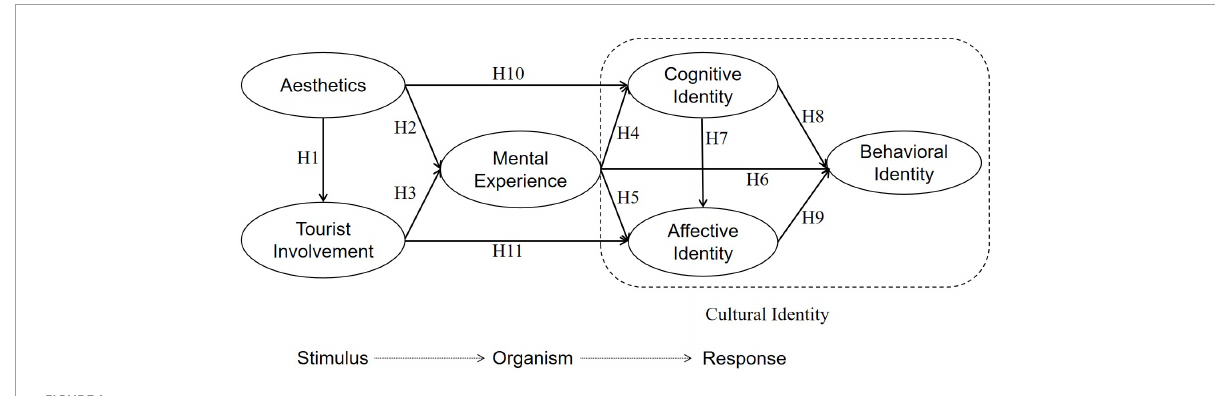
FIGURE1 Tourists’ cultural identity framework in heritage tourism.